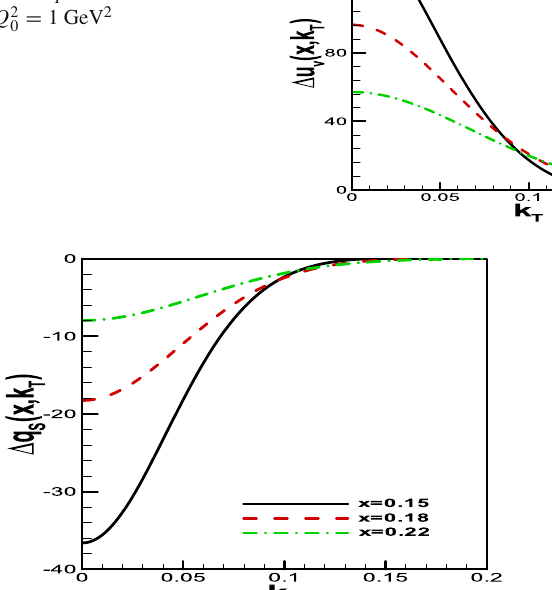
Fig. 10 The k T -distributionoftotalTMDpolarizedseaquarksat Q 2 1 GeV